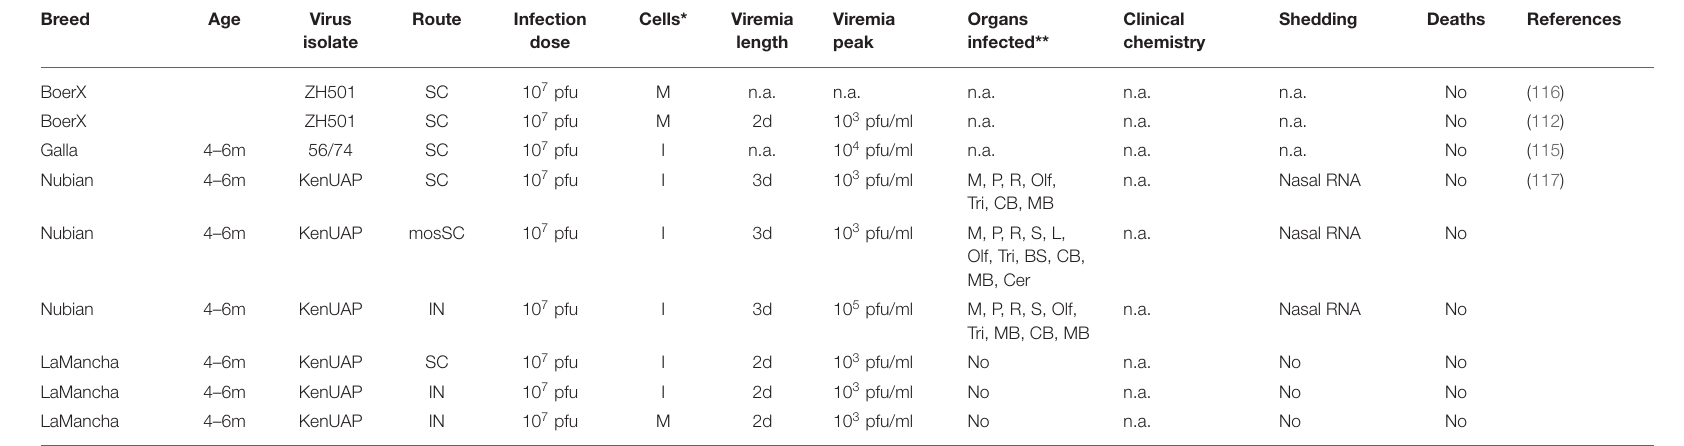
TABLE 3 | Summary of included goat studies involving RVFV challenge. Breed